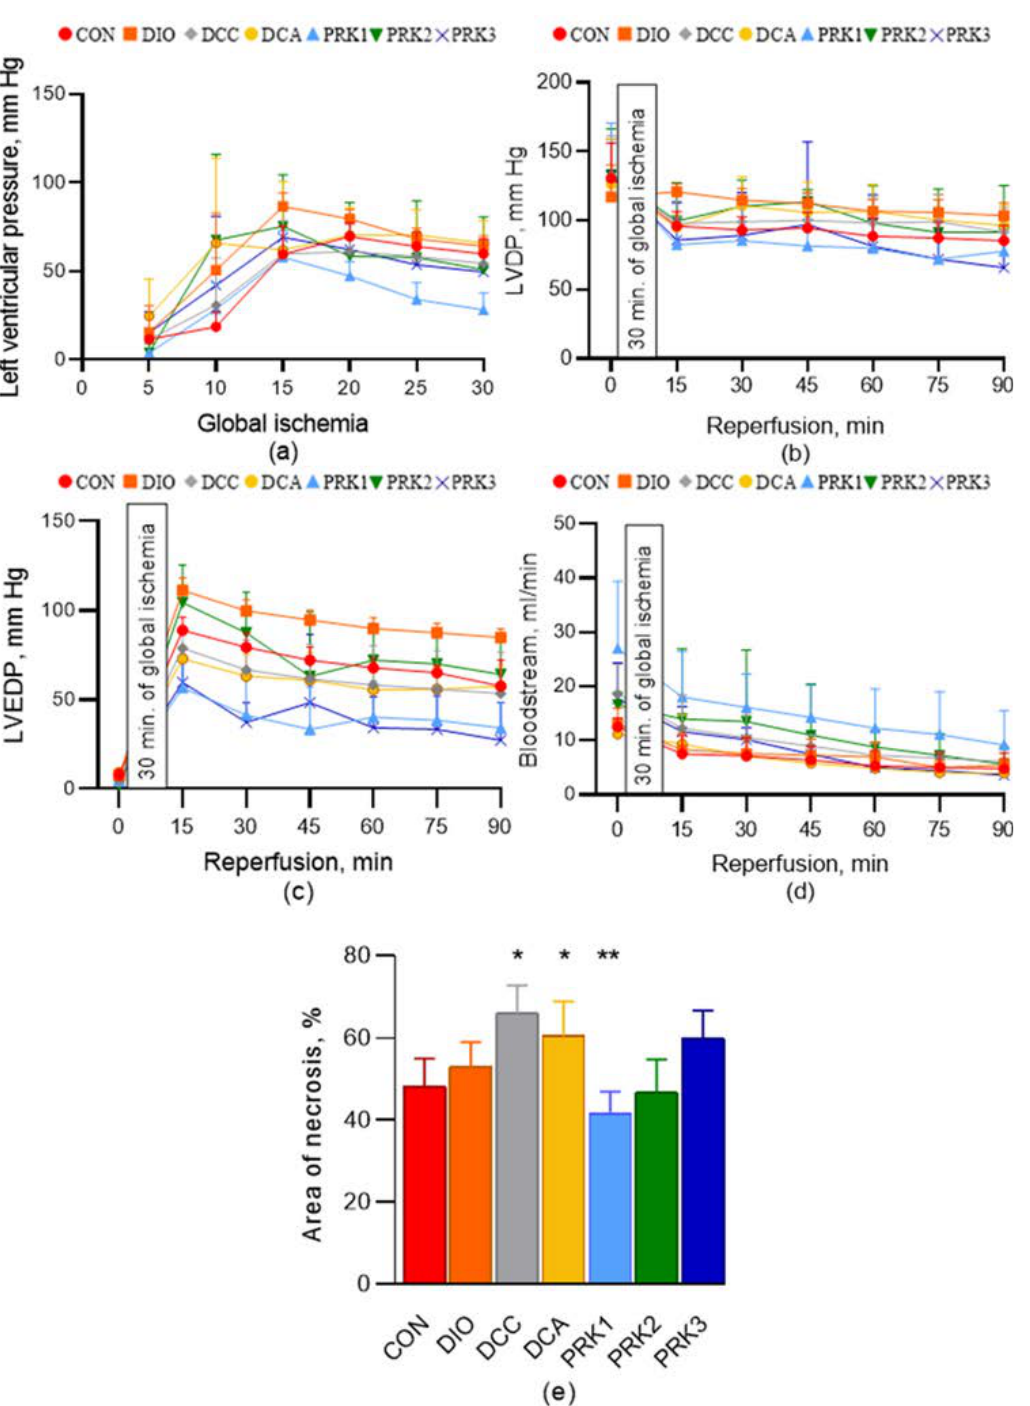
Figure 5. Hemodynamic parameters and necrosis (infarct) size in isolated Langendorff-perfused rat hearts subjected to 30 min of global ischemia and 120 min of reperfusion. ( a ) Ischemic contracture, ( b ) LVDP, ( c ) LVEDP, ( d ) coronary flow rate, and ( e ) area of necrosis. Data are presented as mean ± standard deviation. * indicates p < 0.05 when data is compared to that for the CON group; ** indicates p < 0.05 when data is compared to that for the DCA group.